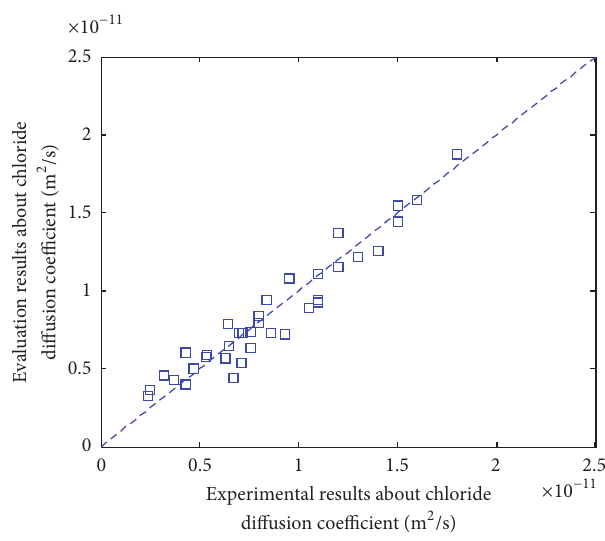
Figure 5: Comparisons between experimental results and analyzed